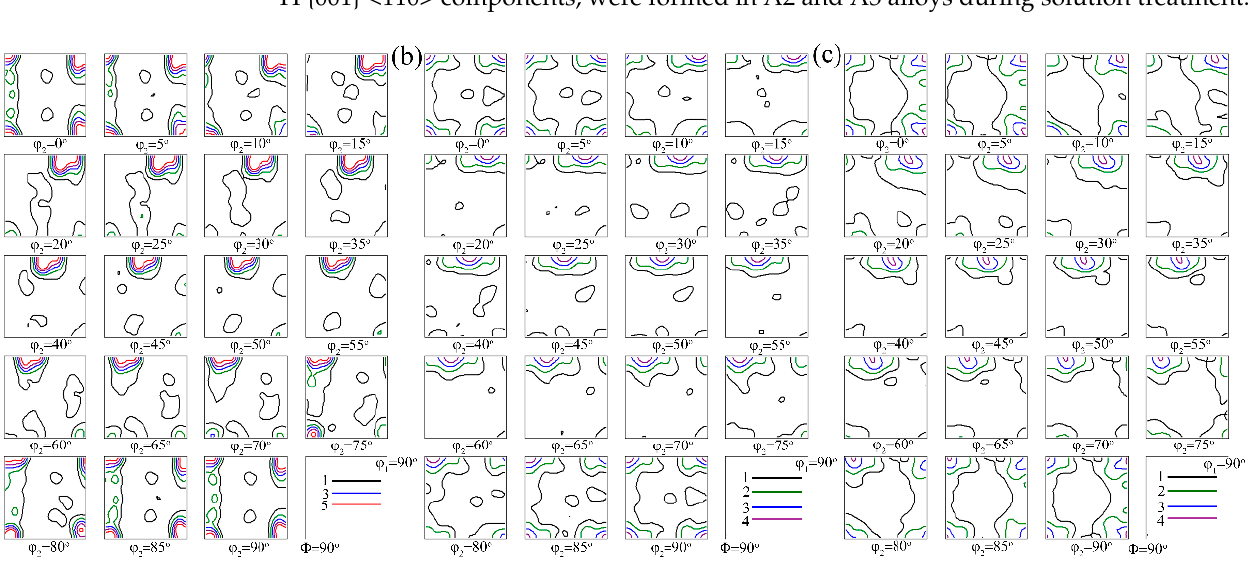
Figure 5. Recrystallized structure of A1, A2, and A3 alloys after solution treatment: ( a ) A1 alloy, ( b ) A2 alloy, and ( c ) A3 alloy.